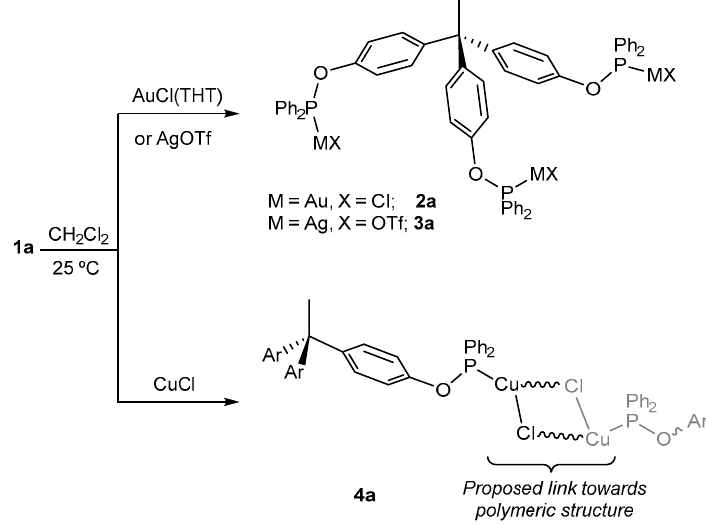
Scheme 2. Synthesis of gold ( 2a ) and silver ( 3a ) trimetallic complexes, and suggested coordination polymer structure of the copper based compound 4a , based on trisphosphinite 1a .